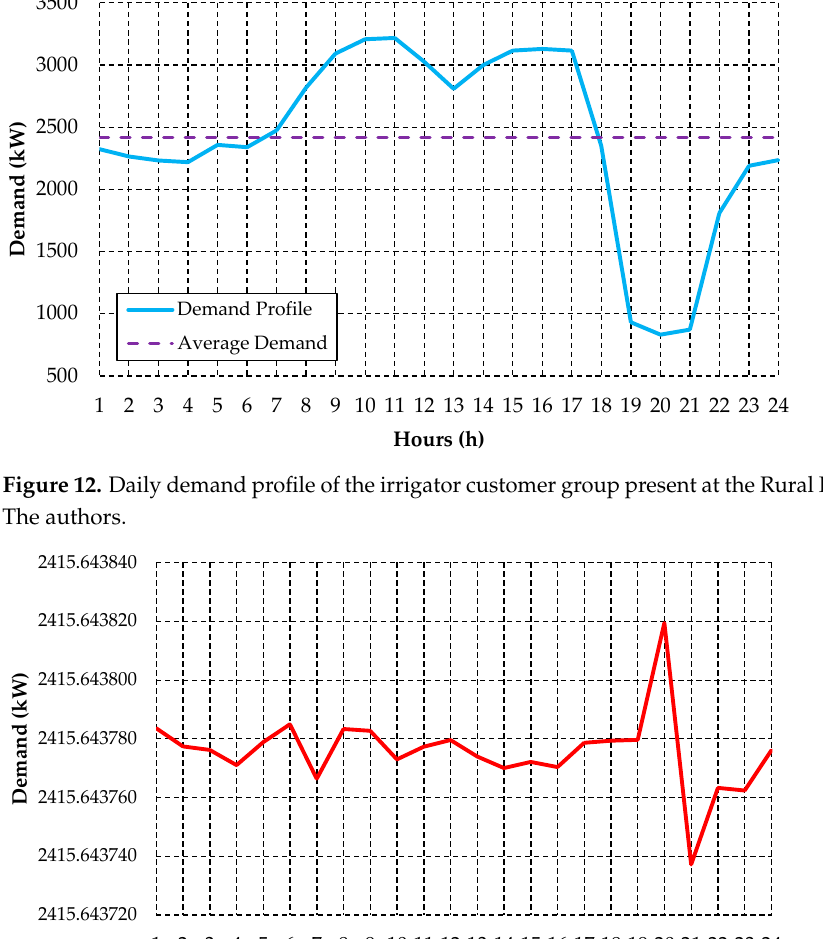
Figure 12. Daily demand profile of the irrigator customer group present at the Rural Feeder A. Source: The authors.